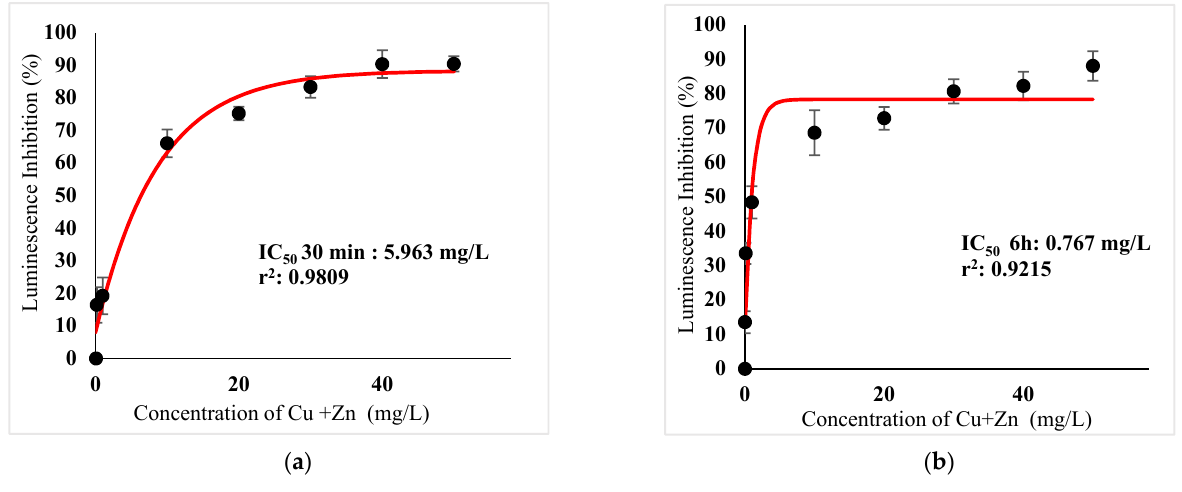
Figure 12. ( a ) Acute and ( b ) Chronic toxicity of mixture Cu 2+ + Zn 2+ in the concentration ratio of 1:1 on luminescence inhibition of Photobacterium sp.NAA-MIE. Data represent mean ± SD, n = 3.